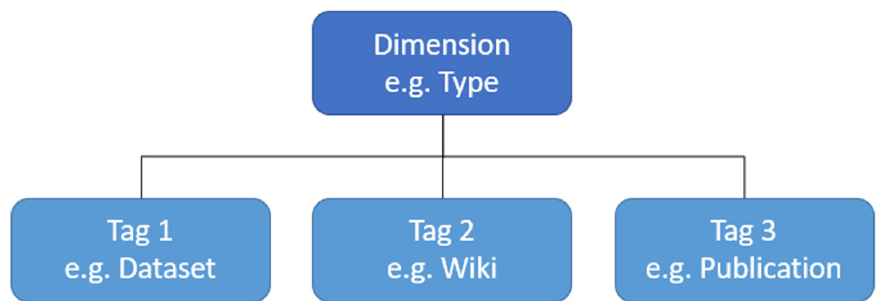
Figure 4. A dimension is a group of tags which are possible concrete terms or keywords of the di- mension.